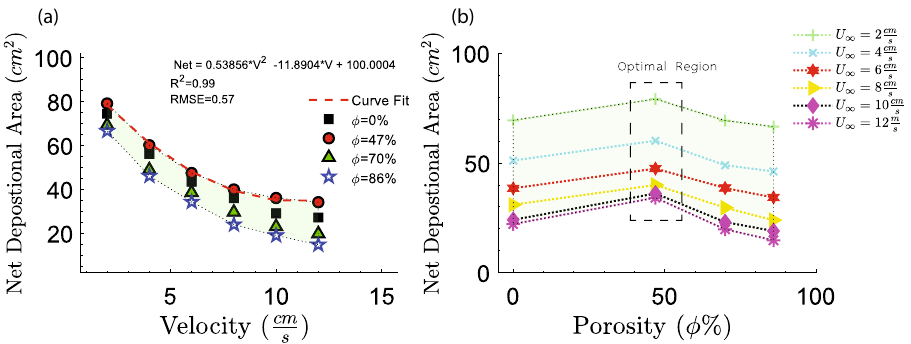
Figure 10. Net depositional area behind the patch versus upstream water velocity ( a ) and patch porosity ( b ) the optimal porosity is φ = 47% and the curve fit shows it variations with the velocity. The green area indicates the region between high and low net depositional